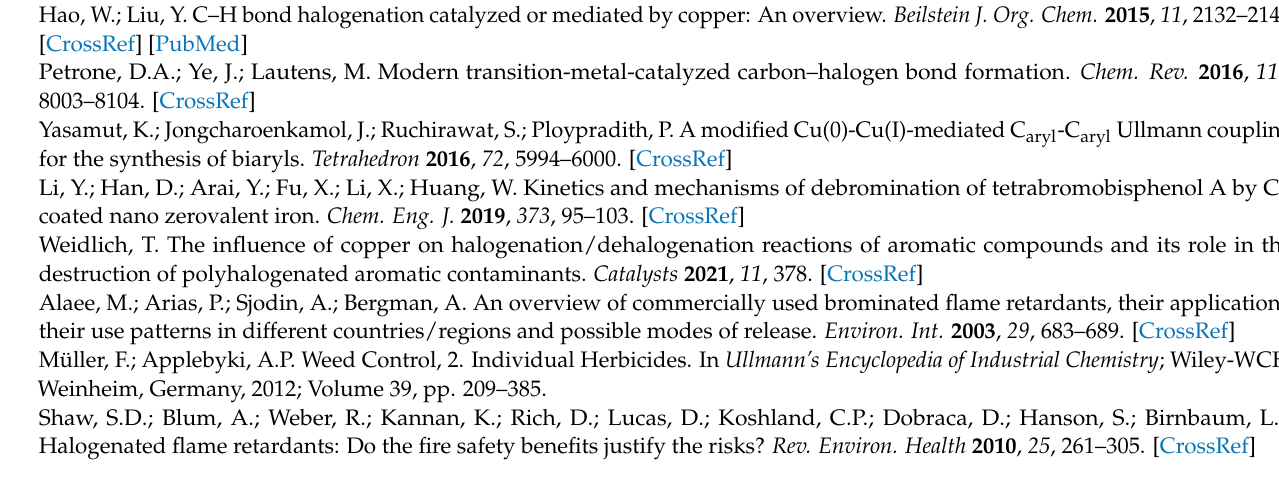
Figure S4: Effect of added NaOH on the HDB of BRX after 18 h of vigorous stirring; Figure S5: HDB rate of 5 mM aq. BRX dissolved in 20 mM aq. NaOH using powdered copper (3.4 g/L) and under the coaction of NaBH 4 (8 g/L) ; Figure S6: Comparison of reductive degradation rates of BRX in aqueous NaOH using Dev. alloy or Cu 2 O/NaBH 4; Figure S7: Comparison of the 1 H NMR spectra of evaporated residue of CH 2 Cl 2 extracts obtained after the reaction of 5 mM BRX in aqueous NaOH with Cu 0 /NaBH 4 (top), excess of Dev. alloy (middle) and nano Cu 0 /NaBH 4 (bottom); Figure S8: Comparison of the 1 H NMR spectra (details of aromatic regions) of evaporated residue of CH 2 Cl 2 extracts obtained after the reaction of 5 mM BRX in aqueous NaOH with Cu 0 /NaBH 4 (top), excess of Dev. alloy (middle) and nanoCu 0 /NaBH 4 (bottom); Figure S9: Comparison of the 1 H NMR spectra (details of aromatic regions) of evaporated residue of CH 2 Cl 2 extracts obtained after the reaction of 5 mM BRX in aqueous NaOH with Cu 0 /NaBH 4 (top), excess of Dev. alloy (middle) and nano Cu 0 /NaBH 4 (bottom); Figure S10: GC-MS analysis of CDCl 3 extract of reaction mixture obtained after HDB of 5 mM BRX dissolved in 20 mM NaOH using nano Cu/NaBH 4 (Table S2, Entry 7) (retention times are given in minutes); Figure S11. (a) GC chromatogram of GC-MS analysis of CDCl 3 extract of reaction mixture obtained after reduction of BRX by in-situ prepared nano Cu + NaBH 4 (Table S6, Entry 12) (retention times are given in minutes). Figure S12: GC-MS analysis of CH 2 Cl 2 extract of reaction mixture described in Table S8, Entry 2, HDB of TBBPA (retention times are given in minutes); Figure S13: GC chromatogram of GC-MS analysis of DCM extract of reaction mixture after complete debromination (using Dev. alloy/NaOH or CuSO 4 /NaBH 4 ), Table S8, Entries 4, 5; Scheme S1: Proposed HDB of BRX using Dev. alloy and aqueous NaOH